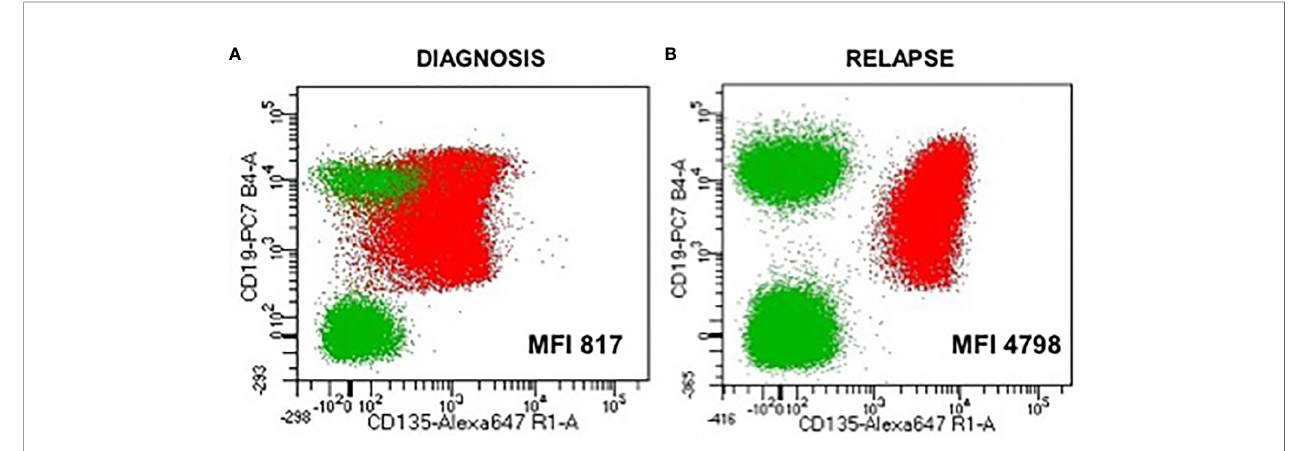
FIGURE 3 | Expression of the FLT3 receptor (CD135) on the blast population at diagnosis and at relapse showing a six times more expression at relapse (B) than at diagnosis (A) ( MFI, mean fl uorescence intensity ) .